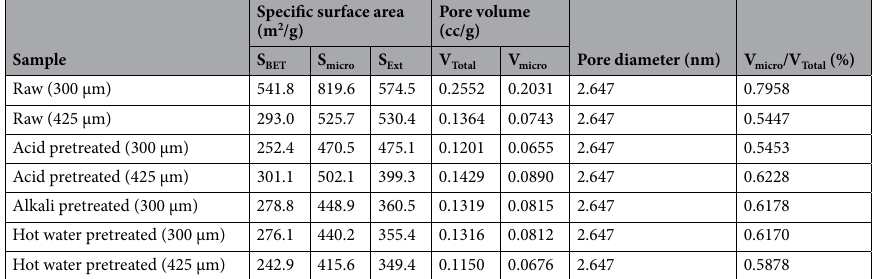
Table 6. Pore characteristics of cassava peels biomass (raw and